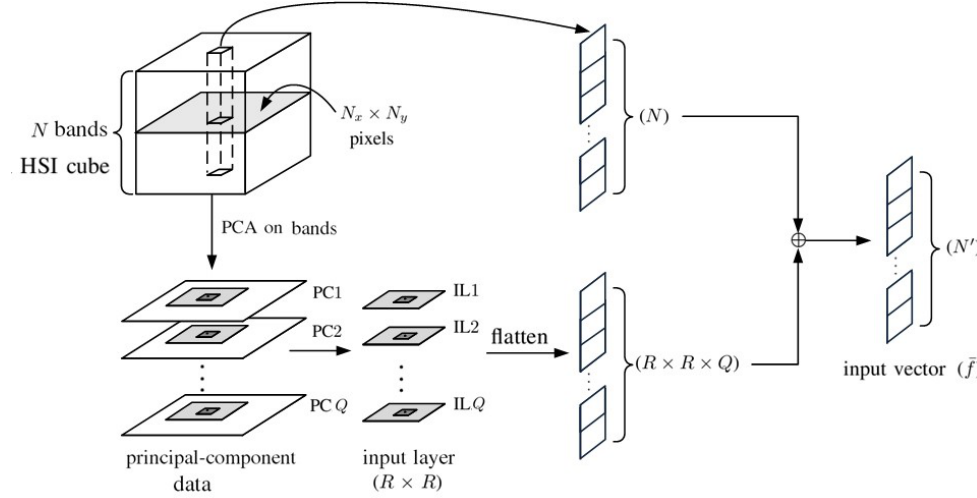
Figure 8. Preparation of an augmented input vector by concatenating pixelwise spectral bands and the principal component analysis (PCA) data surrounding the target pixel.